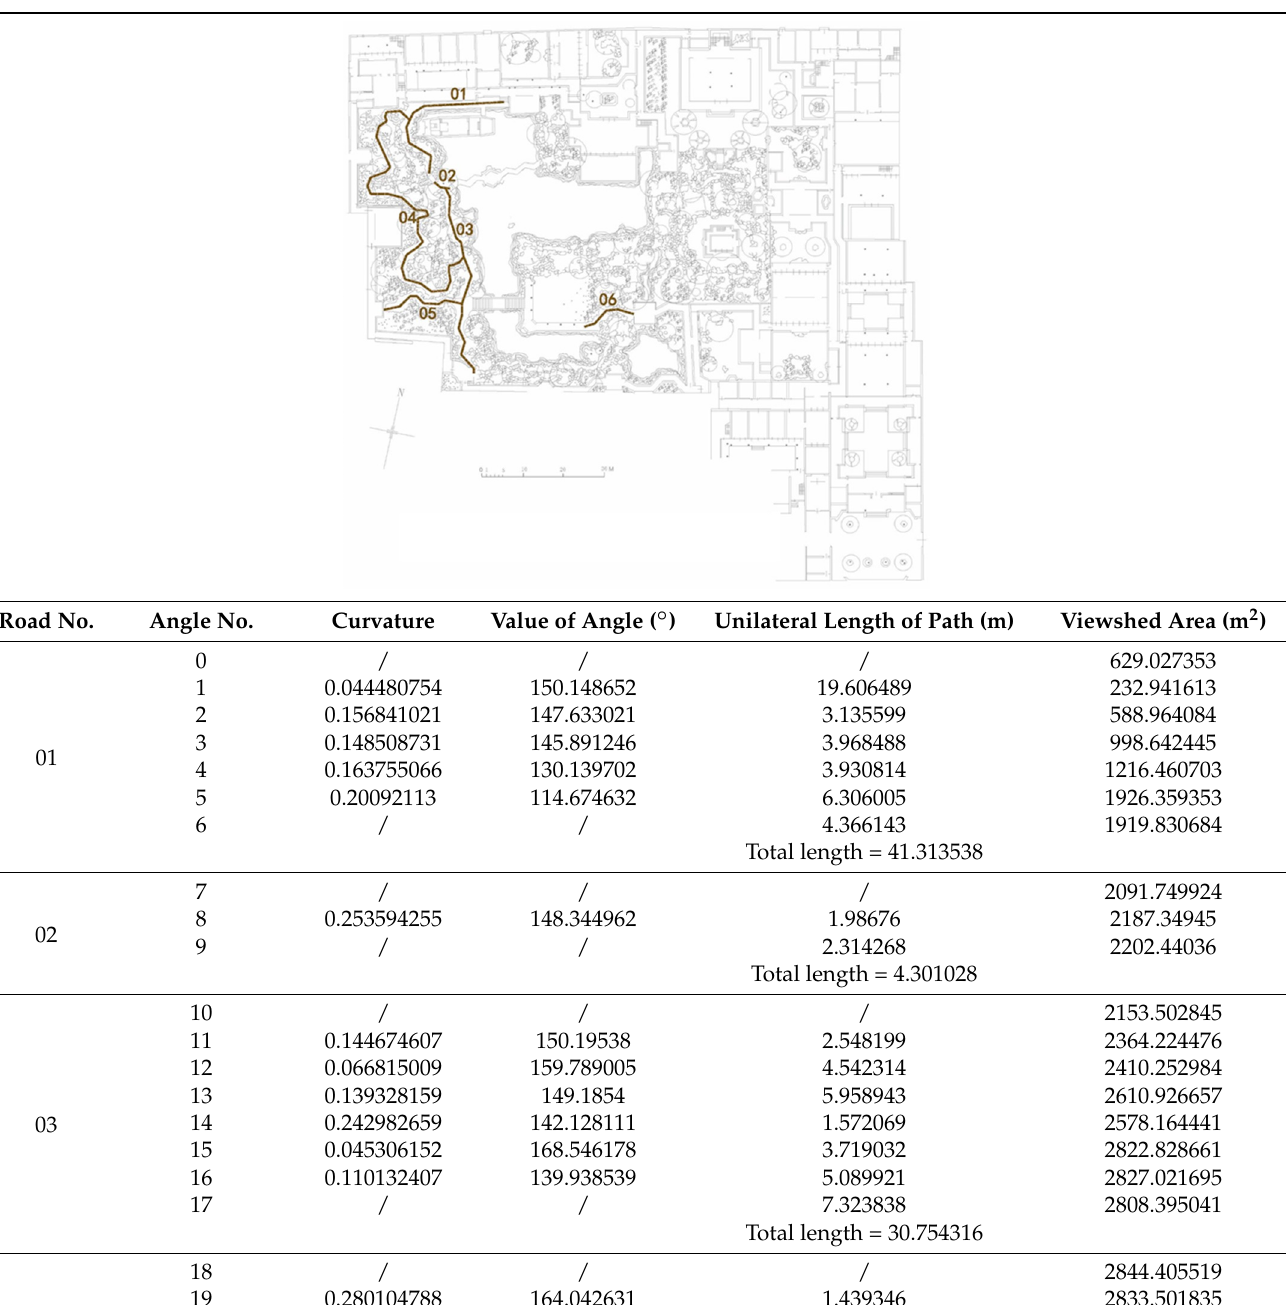
Table A7. Lion Forest Garden, garden path.